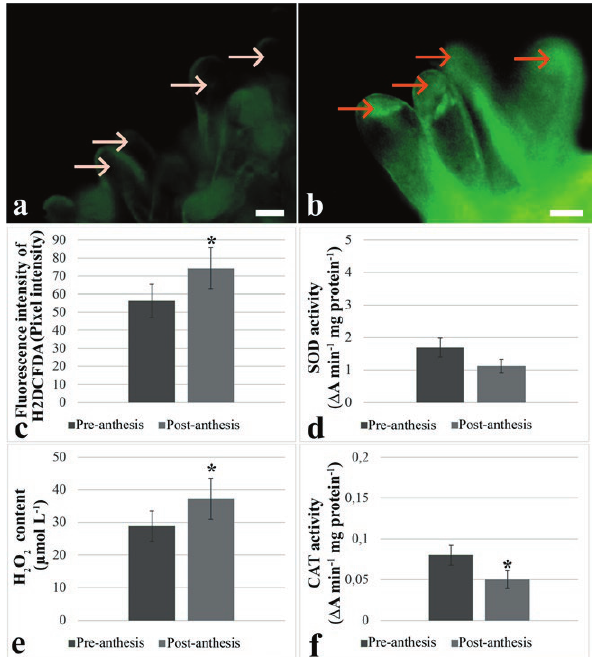
Figure 2. ROS accumulation and antioxidant enzyme activity of papillae at pre-anthesis and post-anthesis. a ROS accumulation at pre-anthesis. b ROS accumulation at post-anthesis. c Fluorescence intensity of H 2 DCFDA at pre-anthesis and post-anthesis. d Change in SOD activity. e Change in H 2 O 2 content. f Change in CAT activ- ity. White arrows indicate the low ROS accumulation and red arrows indicate the high ROS accumulation. Bar: 20 μm.